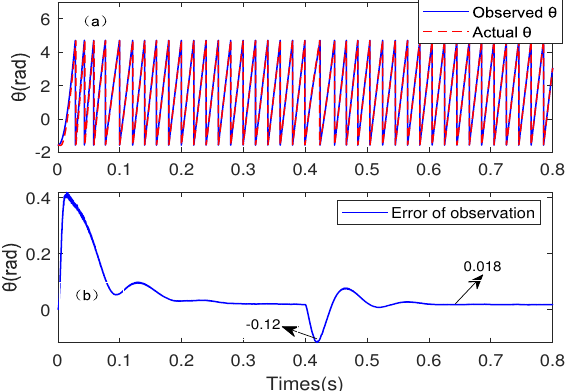
Figure 14. The estimation of rotor position Angle using VPDPI. ( a ) Observed and actual rotor position Angle. ( b ) Rotor position Angle observation error.